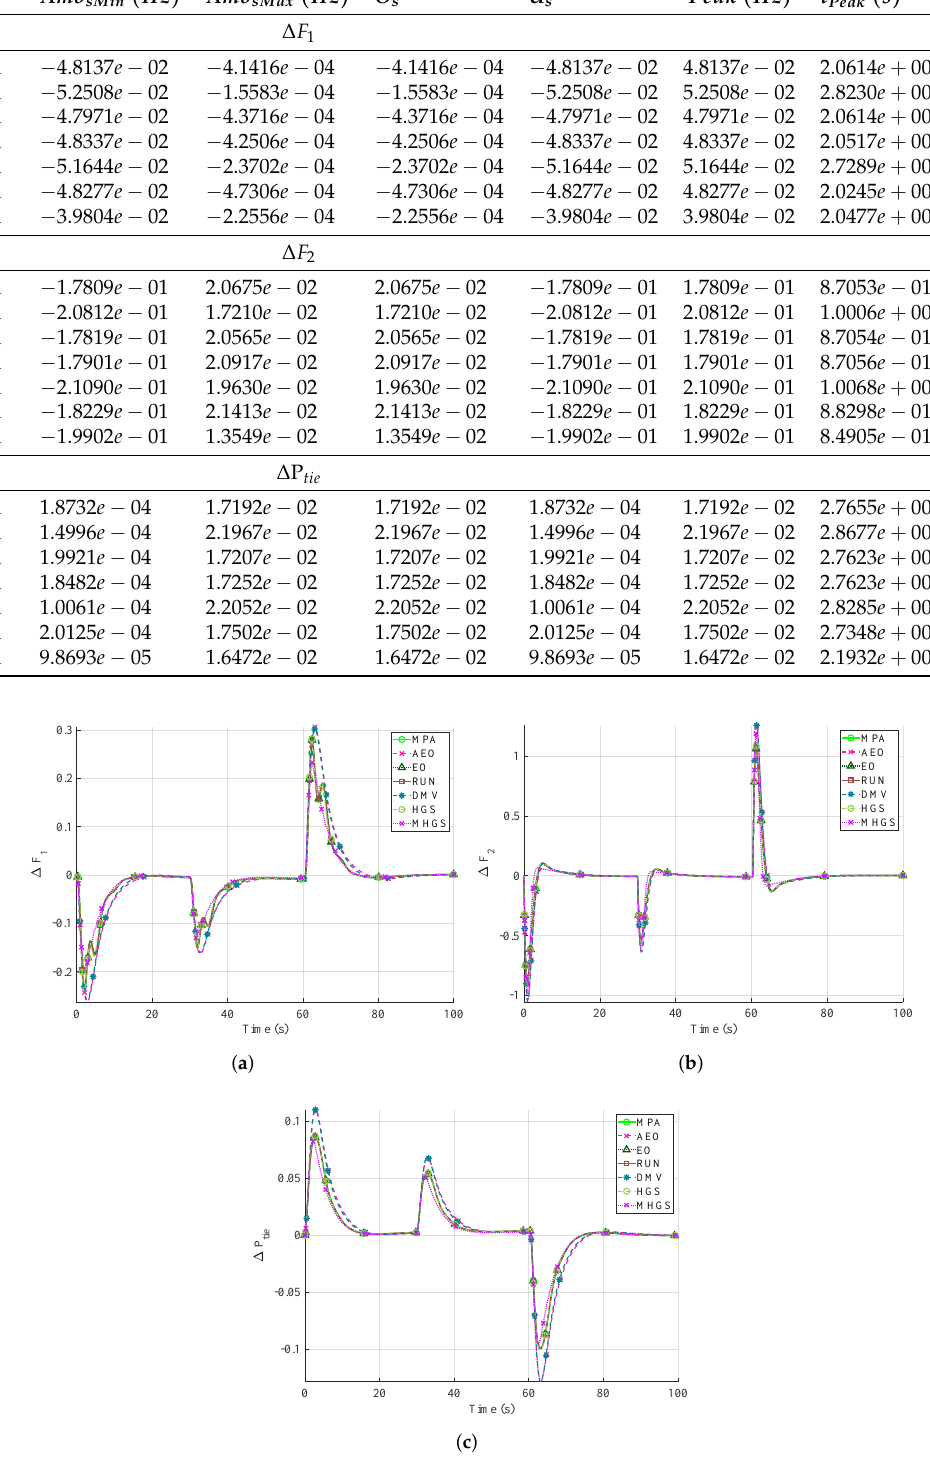
Figure 12. Time responses of variable load disturbance applied on area 2 for: ( a ) ∆ F 1 , ( b ) ∆ F 2 , and ( c ) ∆ P tie